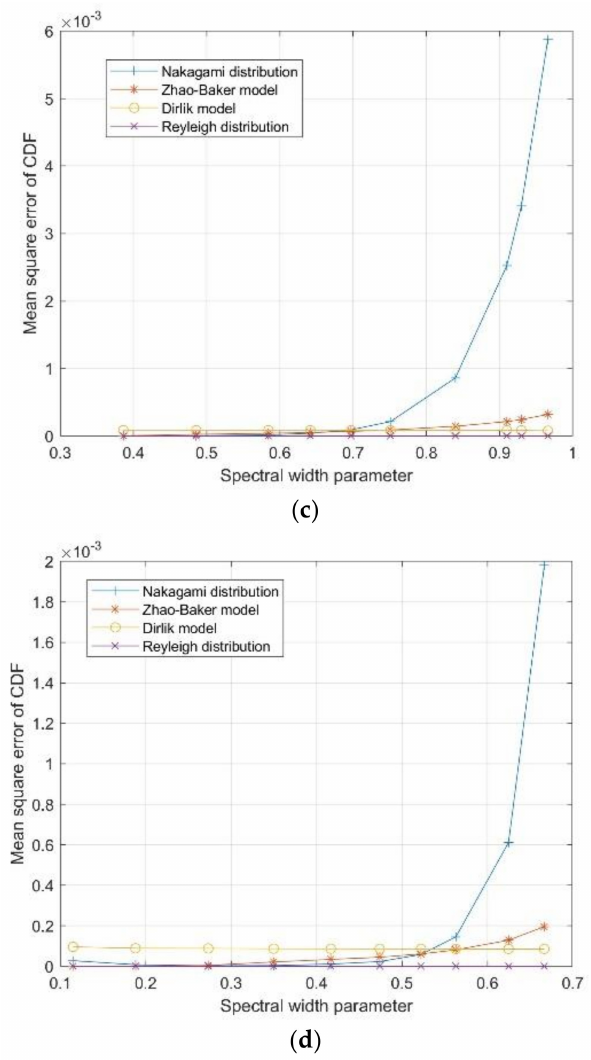
Figure 5. Comparison of RMS errors in CDF by four frequency-domain methods: ( a ) Single peak spectrum; ( b ) bimodal spectrum; ( c ) multi-peak spectrum; ( d ) band-limited white noise